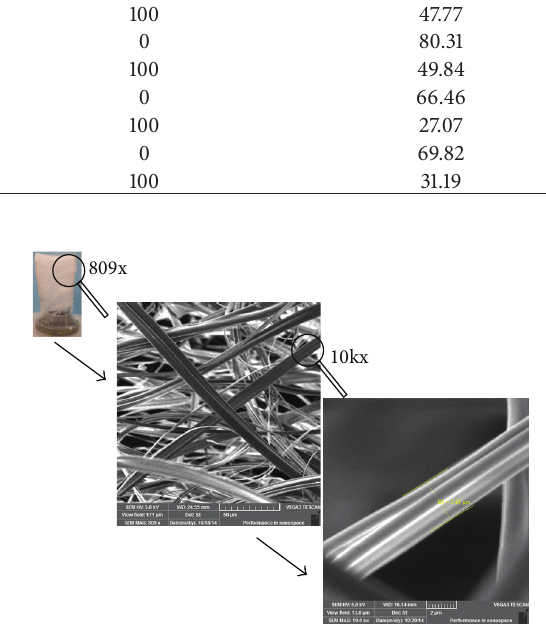
Figure 1: SEM images of electrospun fibers of Eudragit